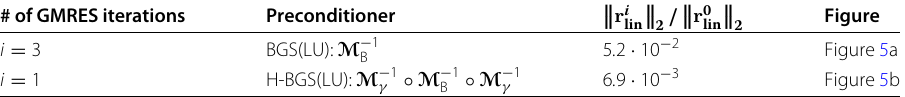
Table2 Proof of concept of hybrid preconditioner applied to the pressure wave example # of GMRES